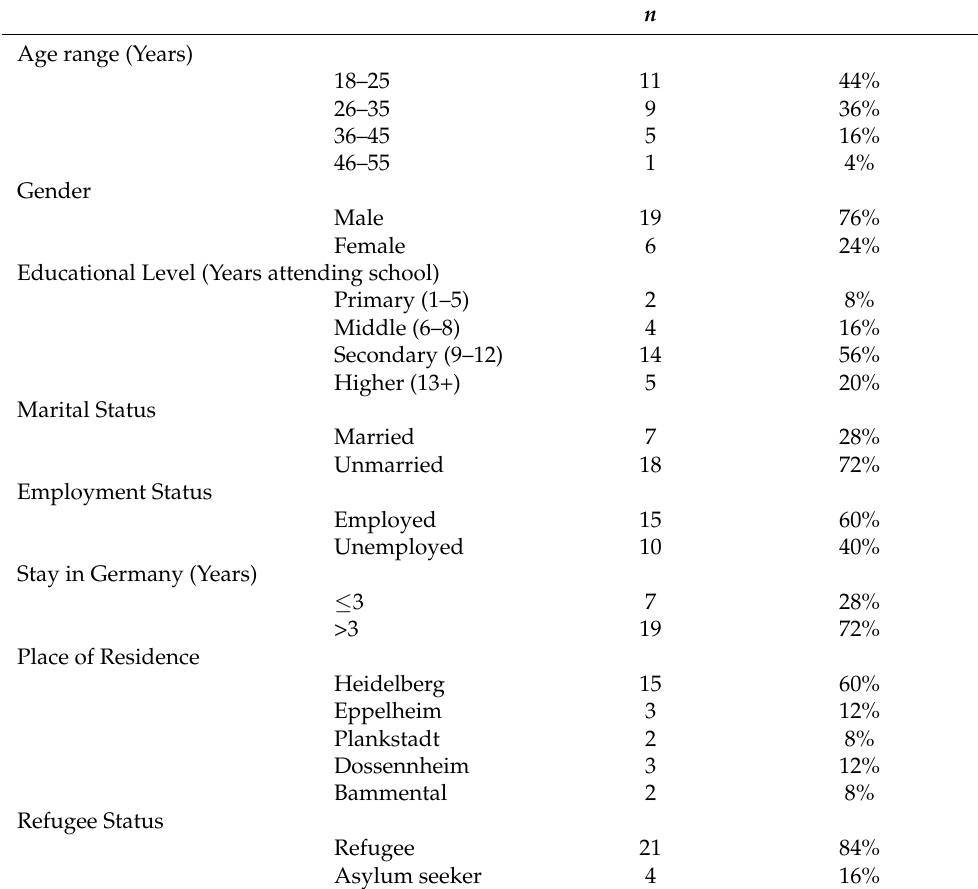
Table 1. Socio-demographic characteristics of